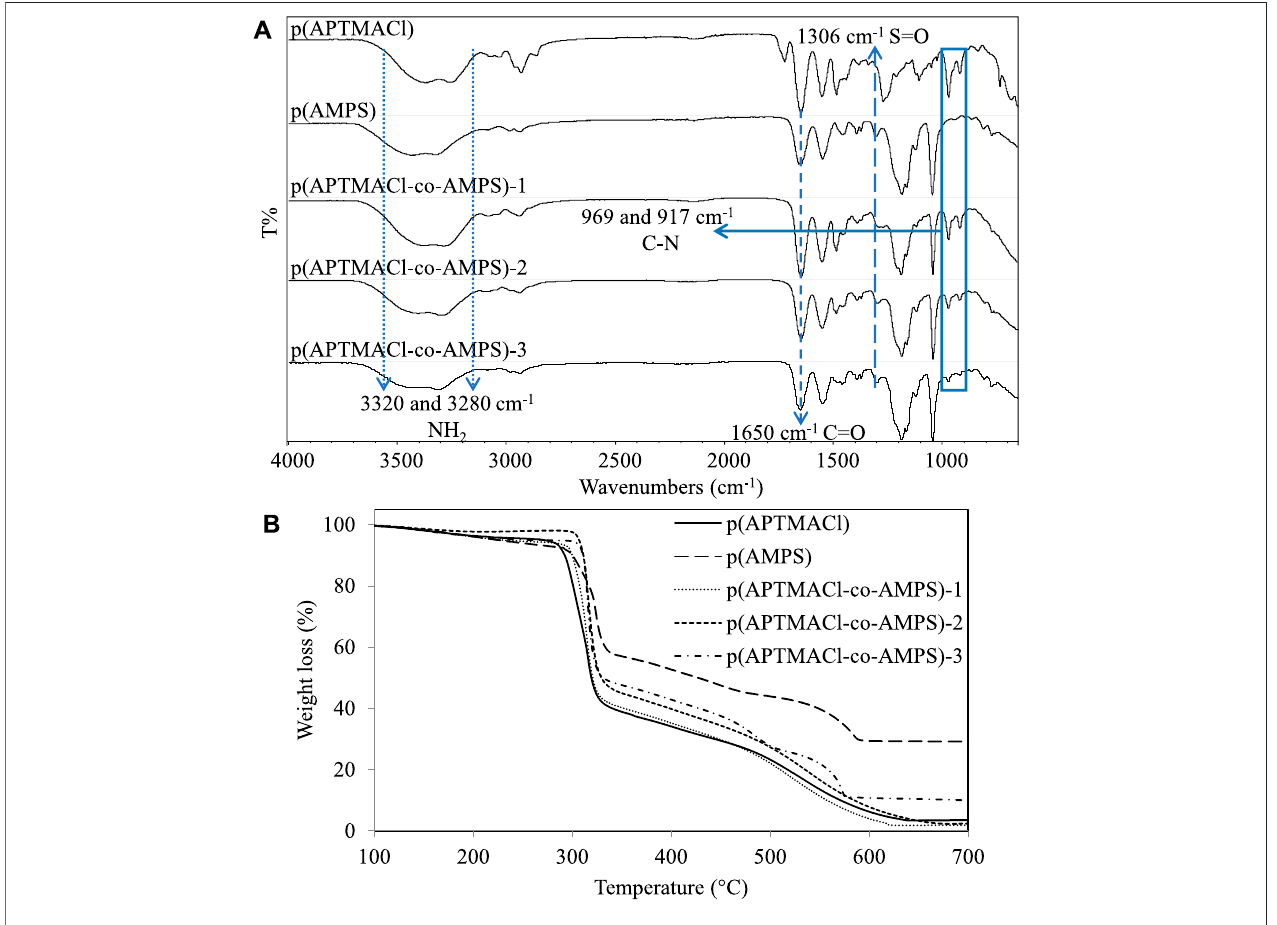
FIGURE 2 | (A) FT-IR spectra and (B) thermal decomposition curves of p (APTMACl), p (AMPS), p (APTMACl-co-AMPS)-1, p (APTMACl-co-AMPS)-2, and p (APTMACl-co-AMPS)-3 hydrogels.